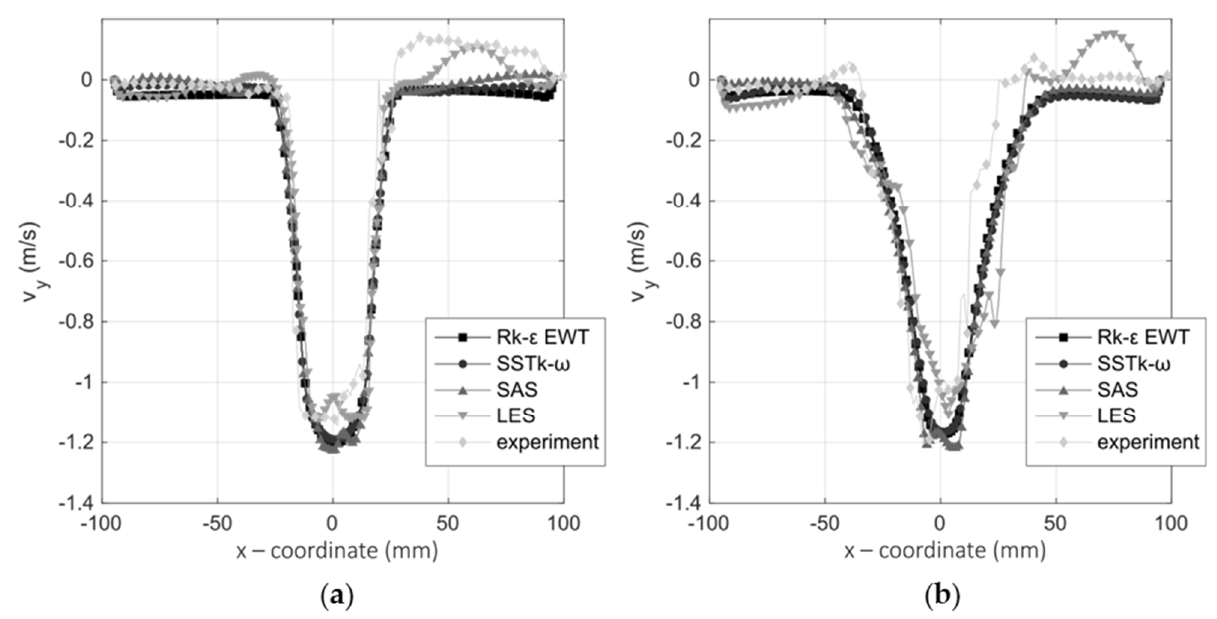
− 50 mm ( a ), and y = − 150 mm ( b